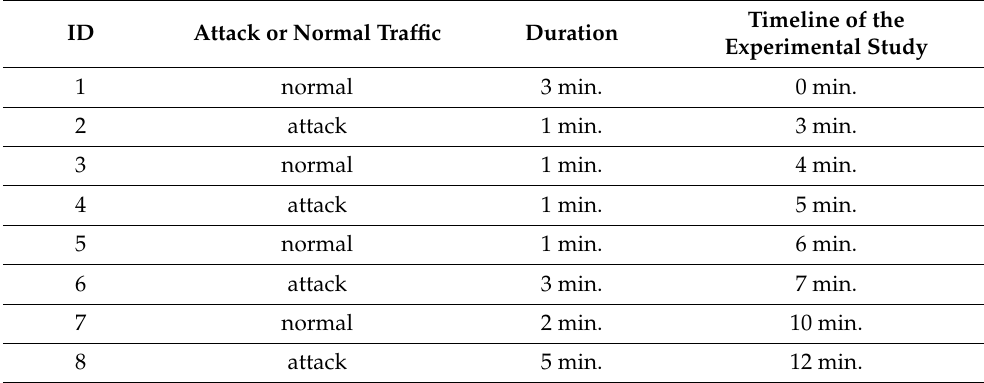
Table 2. Experimental attack schedule for the tests.